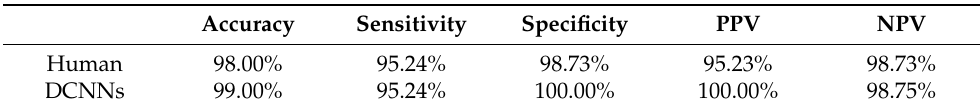
Table 4. Accuracy, sensitivity, specificity, PPV, and NPV of the recognition of high-risk high myopia (class 2).